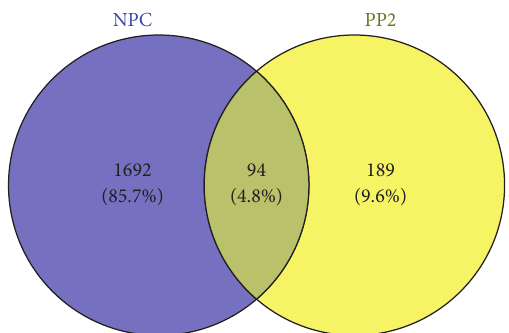
Figure 2: The Venn diagram of potential